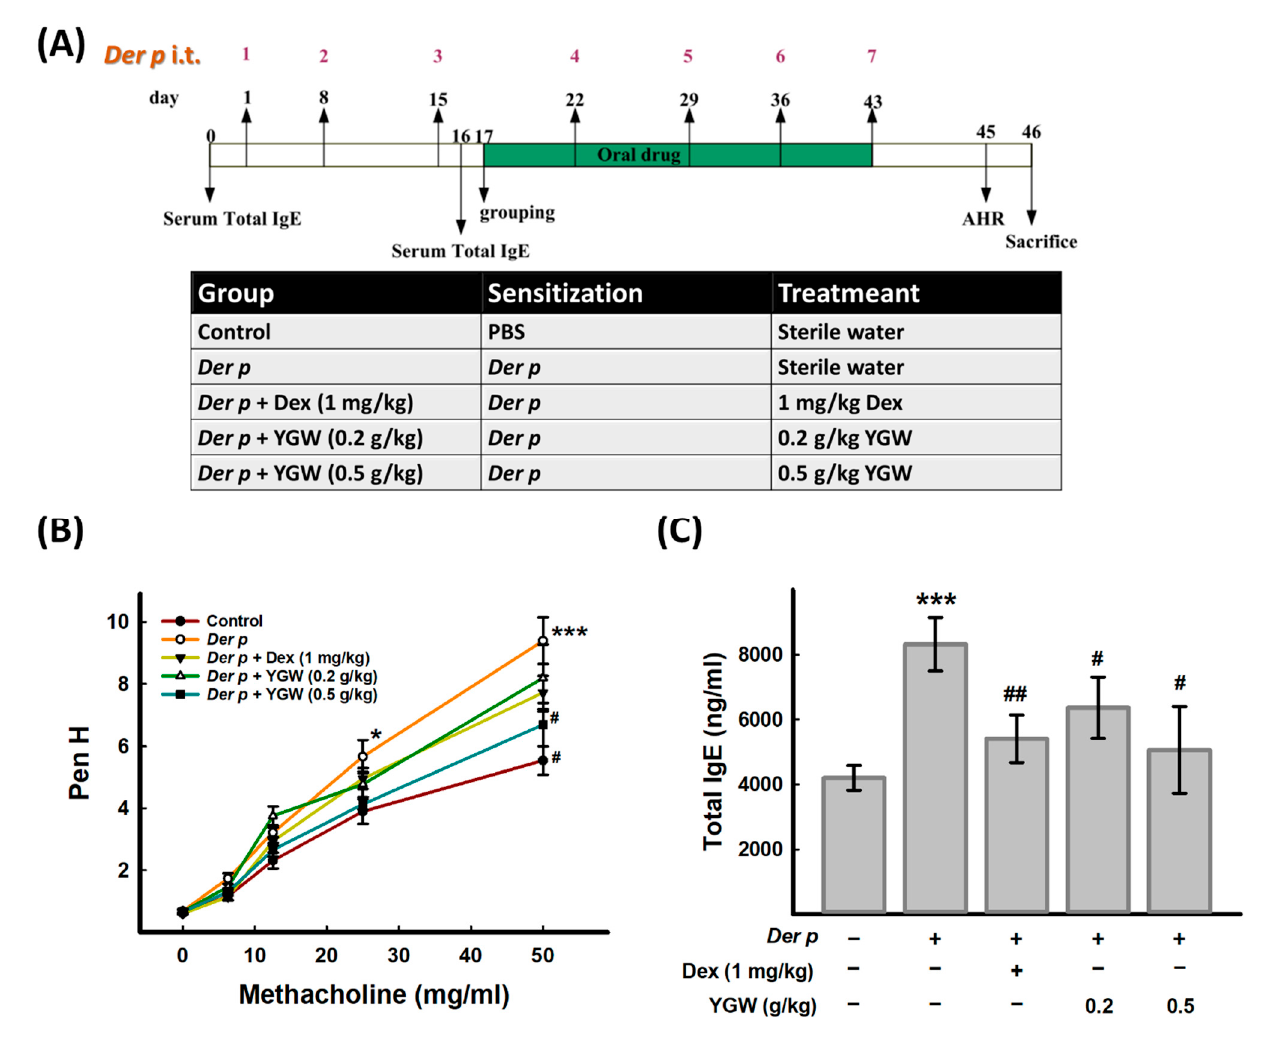
Figure 2. Effect of YGW on airway hyperresponsiveness and serum total IgE in mice. ( A ) A graphical scheme for the timeline of mouse experiments ( B ) Airway hyperresponsiveness was evaluated by methylcholine 2 days after the last tracheal administration of extract of dust mite, Dermatophagoides pteronyssinus ( Der p ). ( C ) Serum total IgE level was measured by using a commercial kit. Data mean ± SEM. *** p < 0.001, * p < 0.05 (vs control); ## p < 0.01, # p < 0.05 (vs. Der p ).